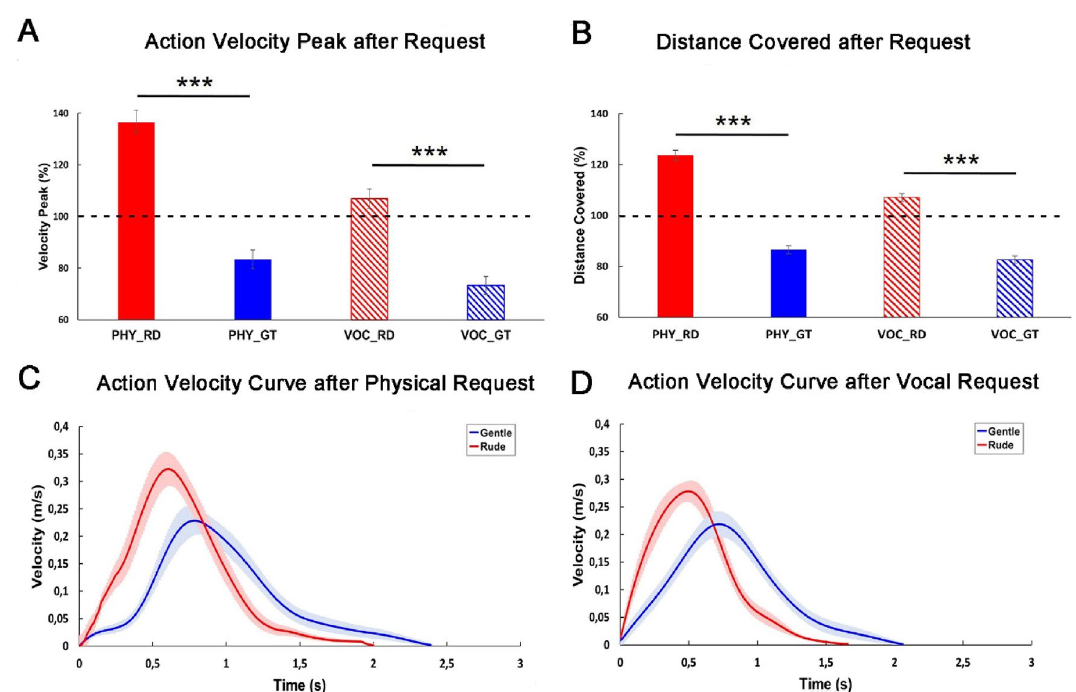
Figure 5. Action velocity peak ( A ) and distance covered ( B ) after request normalized to the baseline condition. Red color refers to rude requests (RD) and blue color refers to gentle requests (GT), both expressed physically (PHY) or vocally (VOC). Graphs in the middle show the action velocity curve characterizing the passage performed by participants after a physical (C) or a vocal (D) request. Error shading indicate standard error of the